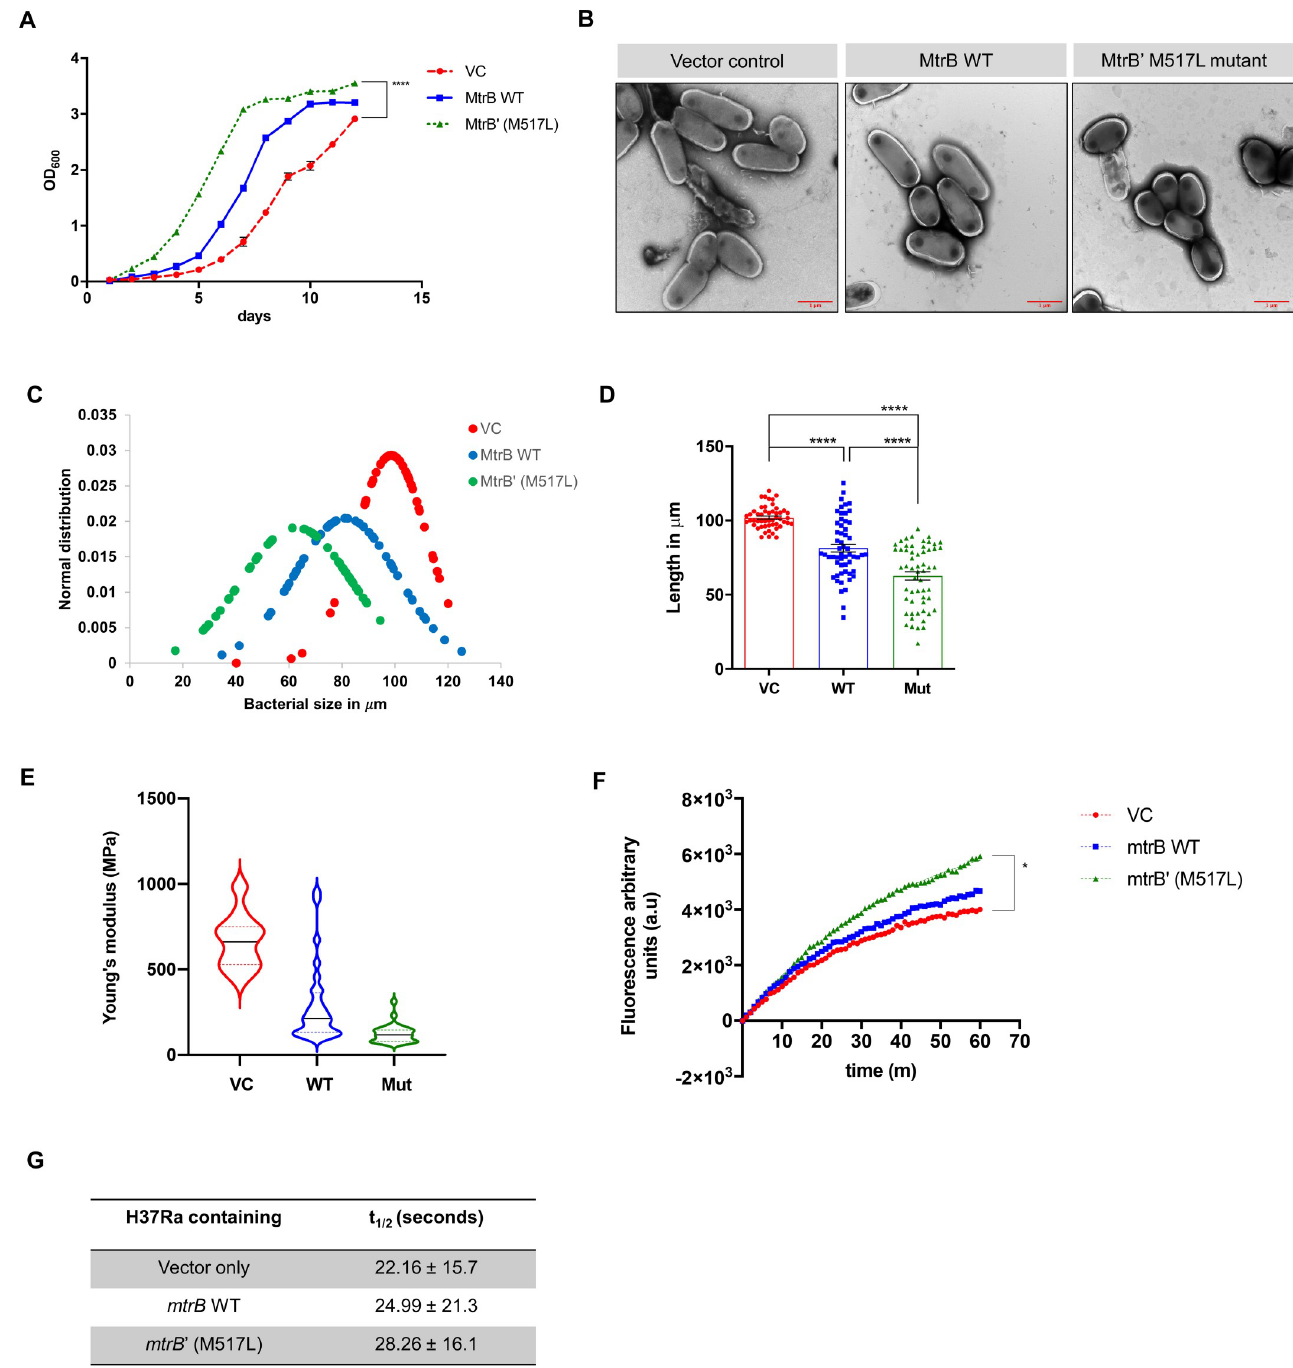
Fig 5. Analysis of growth rates and cell size of strains overexpressing wild-type or mutant MtrB. A. Growth curves of H37Ra strains overexpressing mtrB WT, mtrB ’ (M517L) or the vector alone in 7H9 medium (containing 10% OADC, 0.5% glucose, 0.05% Tween80) (n = 3). B. Transmission electron microscopy analysis (TEM) of recombinant H37Ra strains. Representative micrographs of various strains as indicated. C. Normalized distribution of the bacterial cell length of various strains based on the EM images shown in Fig 5B. D. Average cell length of various strains calculated from EM images shown in Fig 5B. E. Representative topographical images of various strains (as indicated) by atomic force microscopy (AFM). The upper panel of images represent the peak force error maps for each sample and the lower panel of images show the height of each sample. F. Graph showing the nonlinear regression fit of the fluorescence curve obtained for the three strains vector control, mtrB WT and mtrB’ M517L at an excitation-emission of 530–590 obtained after incubation with EtBr (statistical analysis performed only for the last time point of 60min). G. Membrane permeability calculated by the accumulation of EtBr over 60 minutes and represented as t 1/2 in seconds at a concentration of 0.5 μ M of EtBr. The slopes of fluorescence emission curve obtained in Fig 5G were used to determine the t 1/2 value for membrane permeability. For all experiments, n = 3. (P values; � P � 0.05, �� P � 0.01, ��� P � 0.001, ���� P � 0.0001). https://doi.org/10.1371/journal.pone.0256664.g005 PLOS ONE | https://doi.org/10.1371/journal.pone.0256664 September 16,